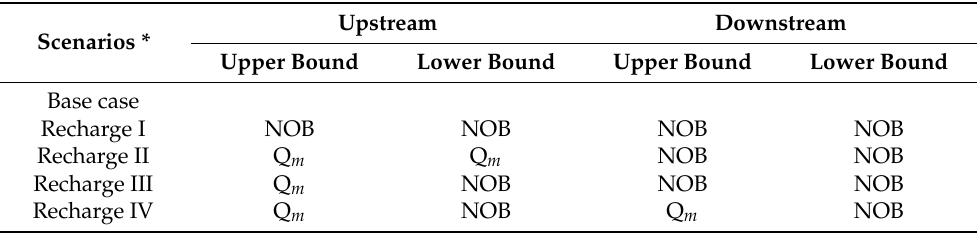
Table 2. Scenarios and network features for the American River water supply network. NOB refers to no bound, and Q m in km 3 /month for month m .